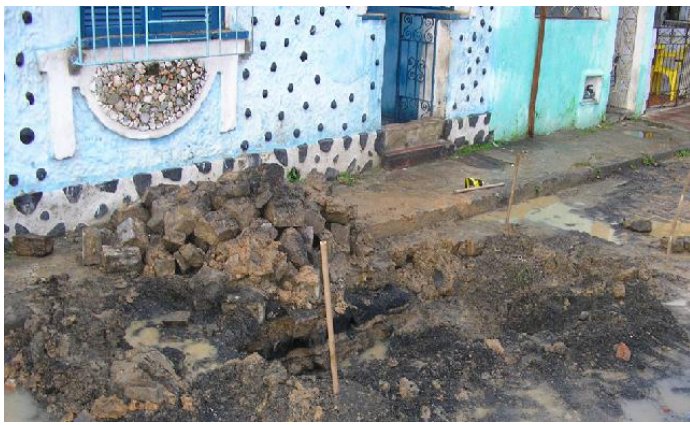
Figure 3. The dross exposed during water pipe repair, 2005.